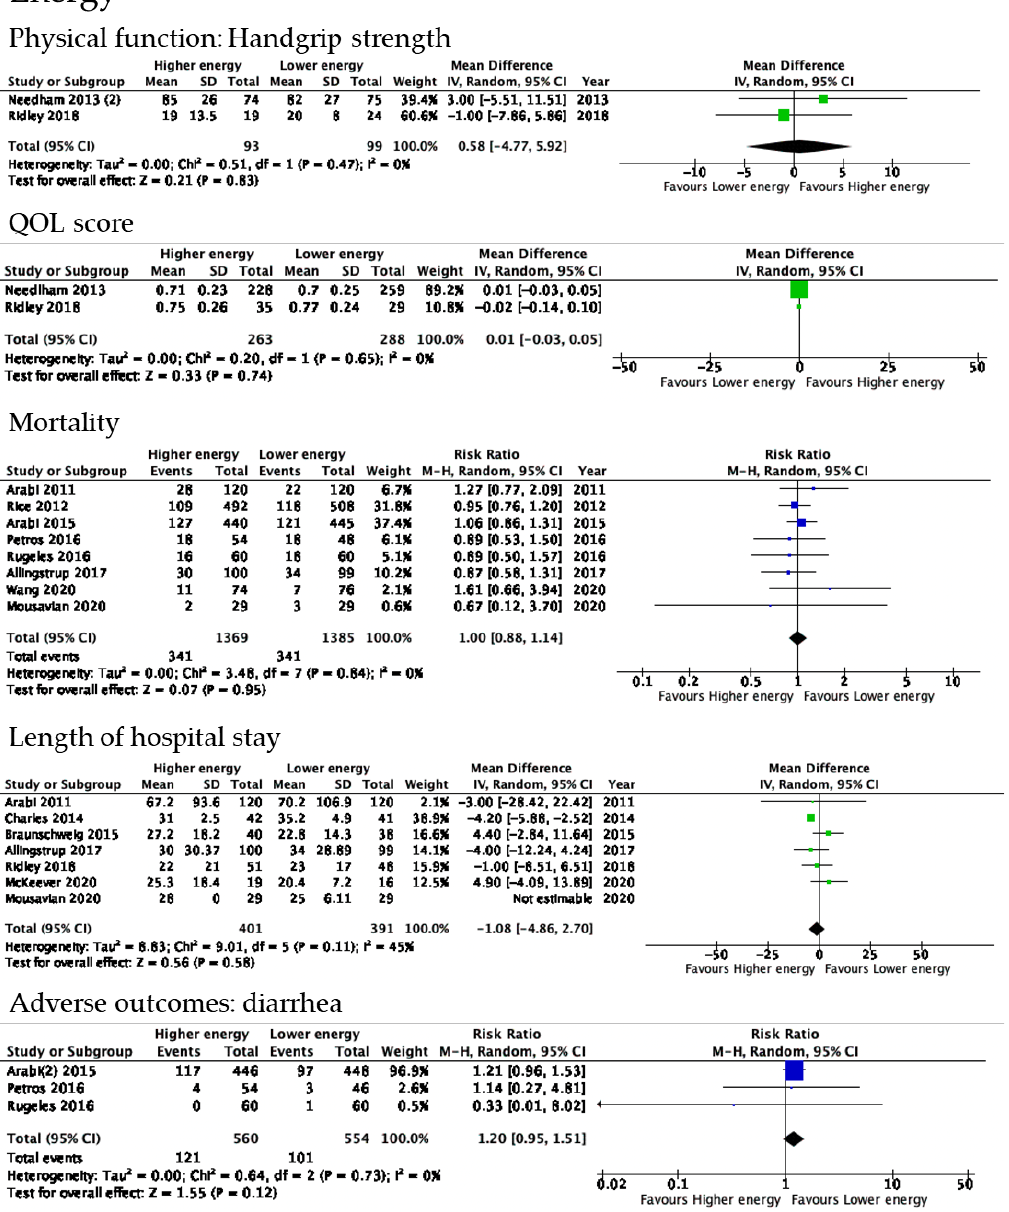
Figure 2. Forest plot of studies included in the optimal energy delivery analysis. Included studies were [26,27] in physical function, [26,27] in QOL score, [29,30,32,34,35,37,39,40] mortality, [28,34], [27,31,39,40,42] in length of hospital stay, [29,32,37] in adverse